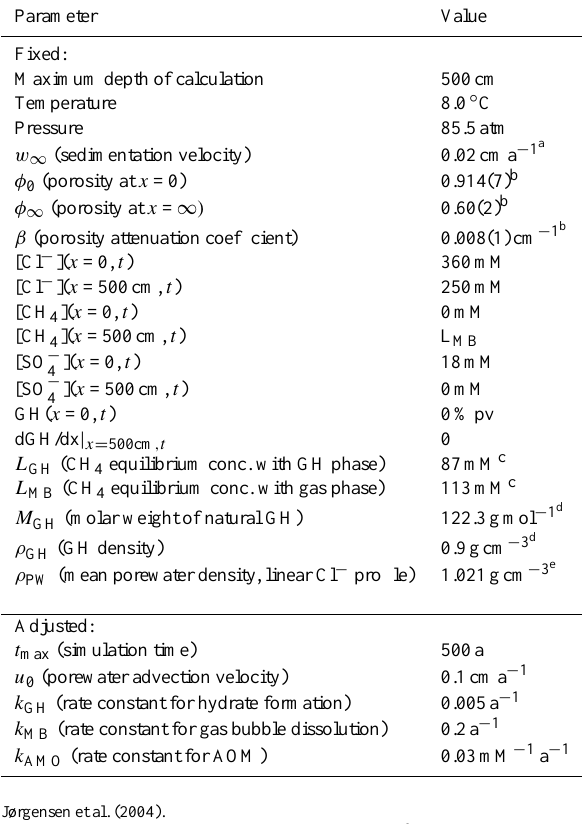
Table A1. Parameters and boundary conditions used in the numeri- cal model.